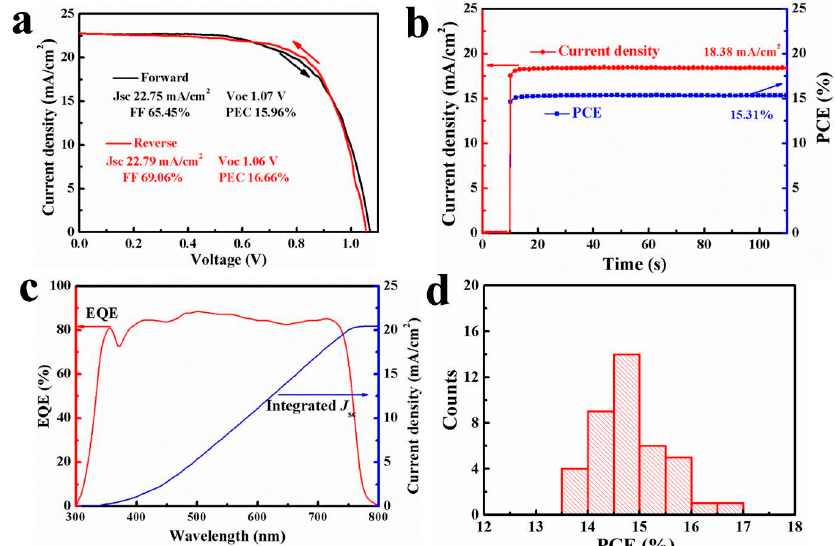
Figure 3. ( a ) Density-voltage (I–V) cures of the best-performing cell, the voltage scan rate is 50 mV/s ( b ) Photocurrent density and PCE as a function of time for the same cell under 0.833 V, ( c ) External quantum efficiency (EQE) spectrum of the best-performing cell, ( d ) Histograms of PCEs measured for 40 cells prepared by using 8 mg/mL MAI in NBA.